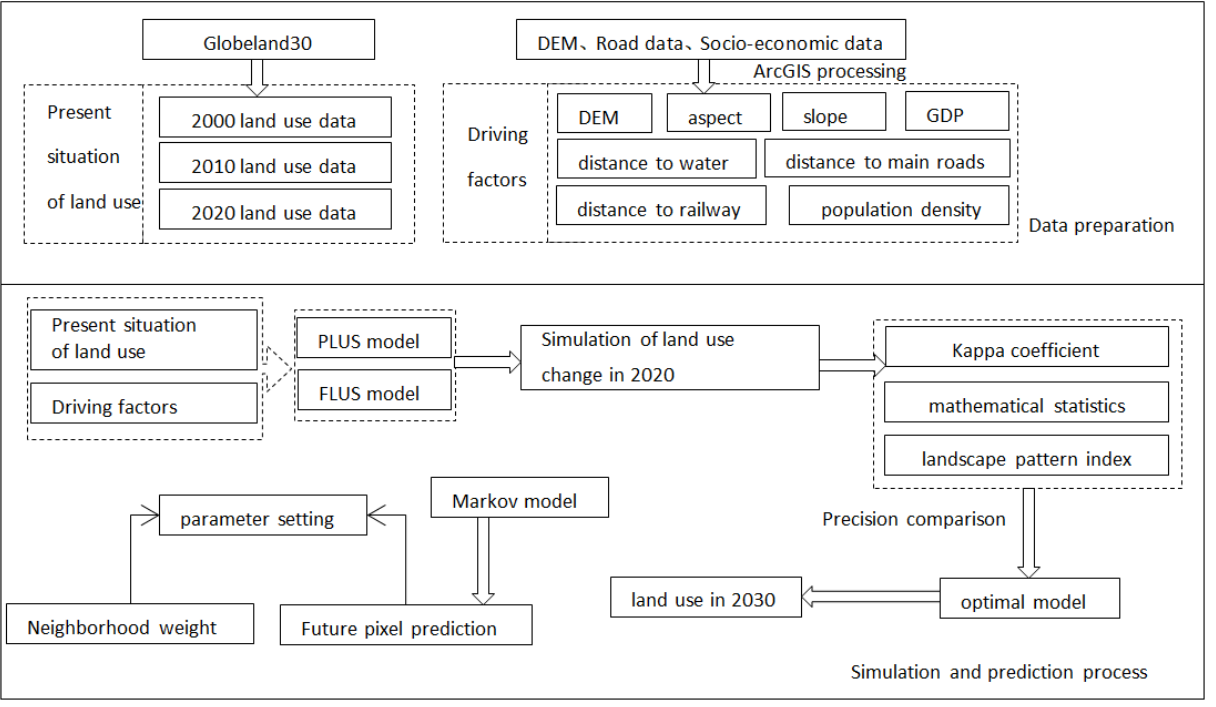
Figure 2. Technical analysis pathway for data preparation, simulation, analysis and prediction pro- cesses.